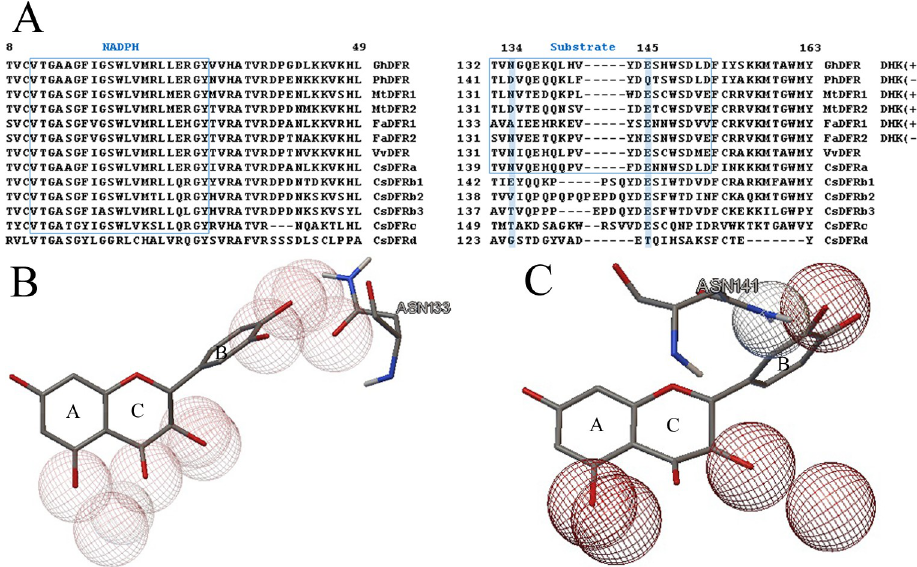
Fig 2. Alignment of amino acid sequences of putative CsDFRs with two types of DFRs (utilizing DHK or not) and interactions between enzyme DFR and substrate DHQ. (A) Alignment of amino acid sequences. The numbers on the top indicate residuals of GhDFR, corresponding to those used by Johnson et al. [20]. The box named “NADPH”: NADPH-binding domain. The box named “Substrate”: substrate-specificity-determining region. (+) or (-) for “DHK” on the right of DFR sequences indicates whether these characteried DFRs accept DHK as substrate (Asp-type) or not (Asn-type). The accession numbers of the protein sequences are as follows: Gh ( Gerbera hybrida ): P51105.1; Ph ( Petunia hybrida ): P14720.2; Mt ( Medicago truncatula ): AAR27014.1, AAR27015.1; Fa ( Fragaria x ananassa ; Strawberry): AHL46444.1, AHL46451.1; Vv ( Vitis vinifera ): P93799; Cs ( Camellia sinensis , see Table 1). (B) Interaction between VvDFR and DHQ from Protein Data Bank (PDB): 2C29. Three rings of DHQ were marked as A, C, B, respectively. Hydrogen bonds were displayed as wireframe spheres. (C) Interaction between CsDFRa and DHQ. Asn141 equals to Asn133 in VvDFR and N134 in GhDFR. More details could be referred to S1